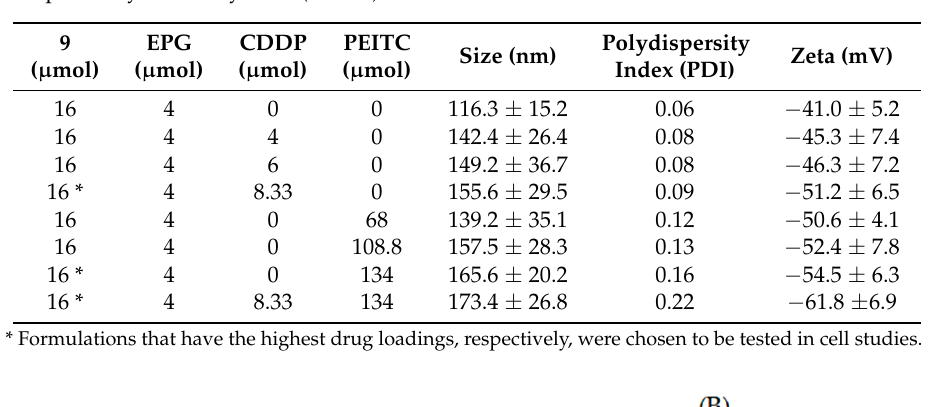
Table 2. Size and zeta potentials of blank liposomes and liposomes loaded with cisplatin (CDDP) and/or phenethyl isothiocyanate (PEITC).